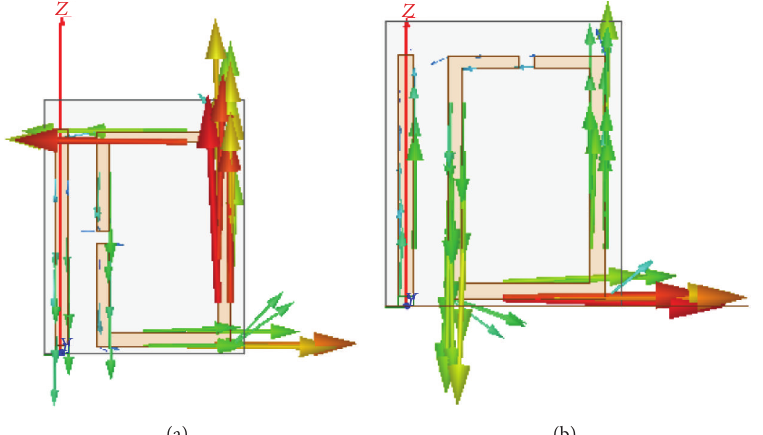
Figure 3: Simulated surface current for the single NFRP element reconfigurable antenna. (a) S1 ON and S2 OFF ( 𝑓 𝑅 = 1.55 GHz), and (b) S1 OFF and S2 ON ( 𝑓 𝑅 = 1.72